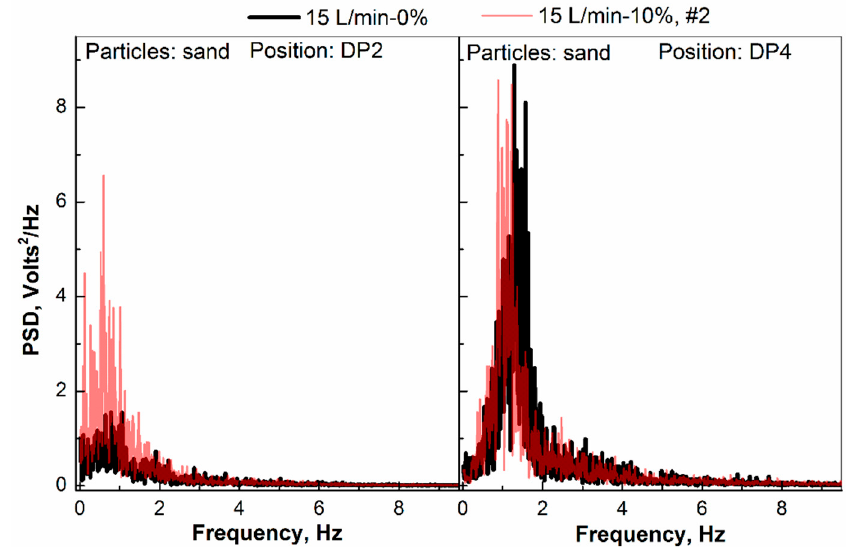
Figure 15. Power spectra of differential pressure measured at DP2 and DP4 with activated membrane #2 for gas extraction. The other operational conditions were: T = 550 °C, P = 0.1 MPa, H ini = 1.28 m, U = 0.09 m/s, addition rate = 1.5 L/min, silica sand.